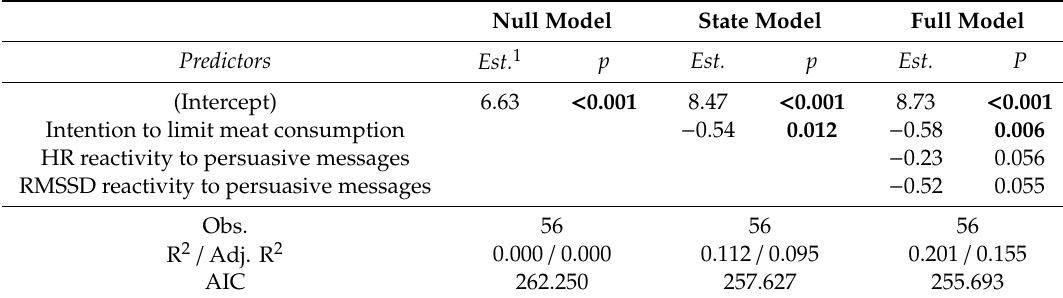
Table 5. Results of three linear models explaining variance in reactance.